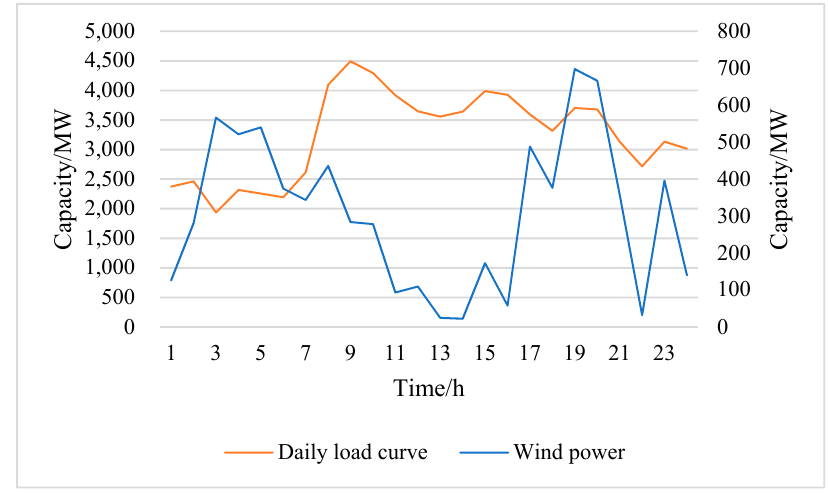
Figure 9. New energy reverse peak adjustment output.